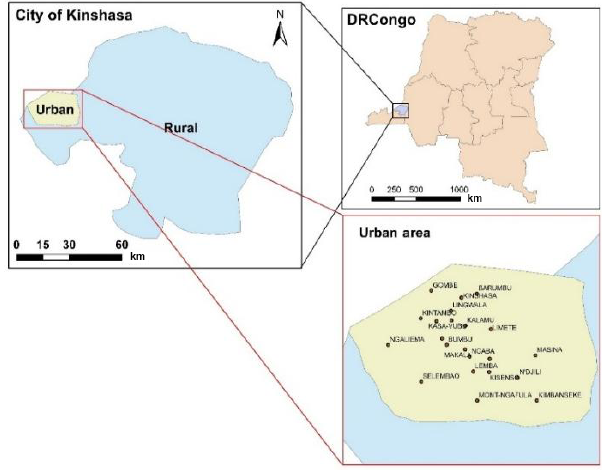
Figure 1. Location of the study